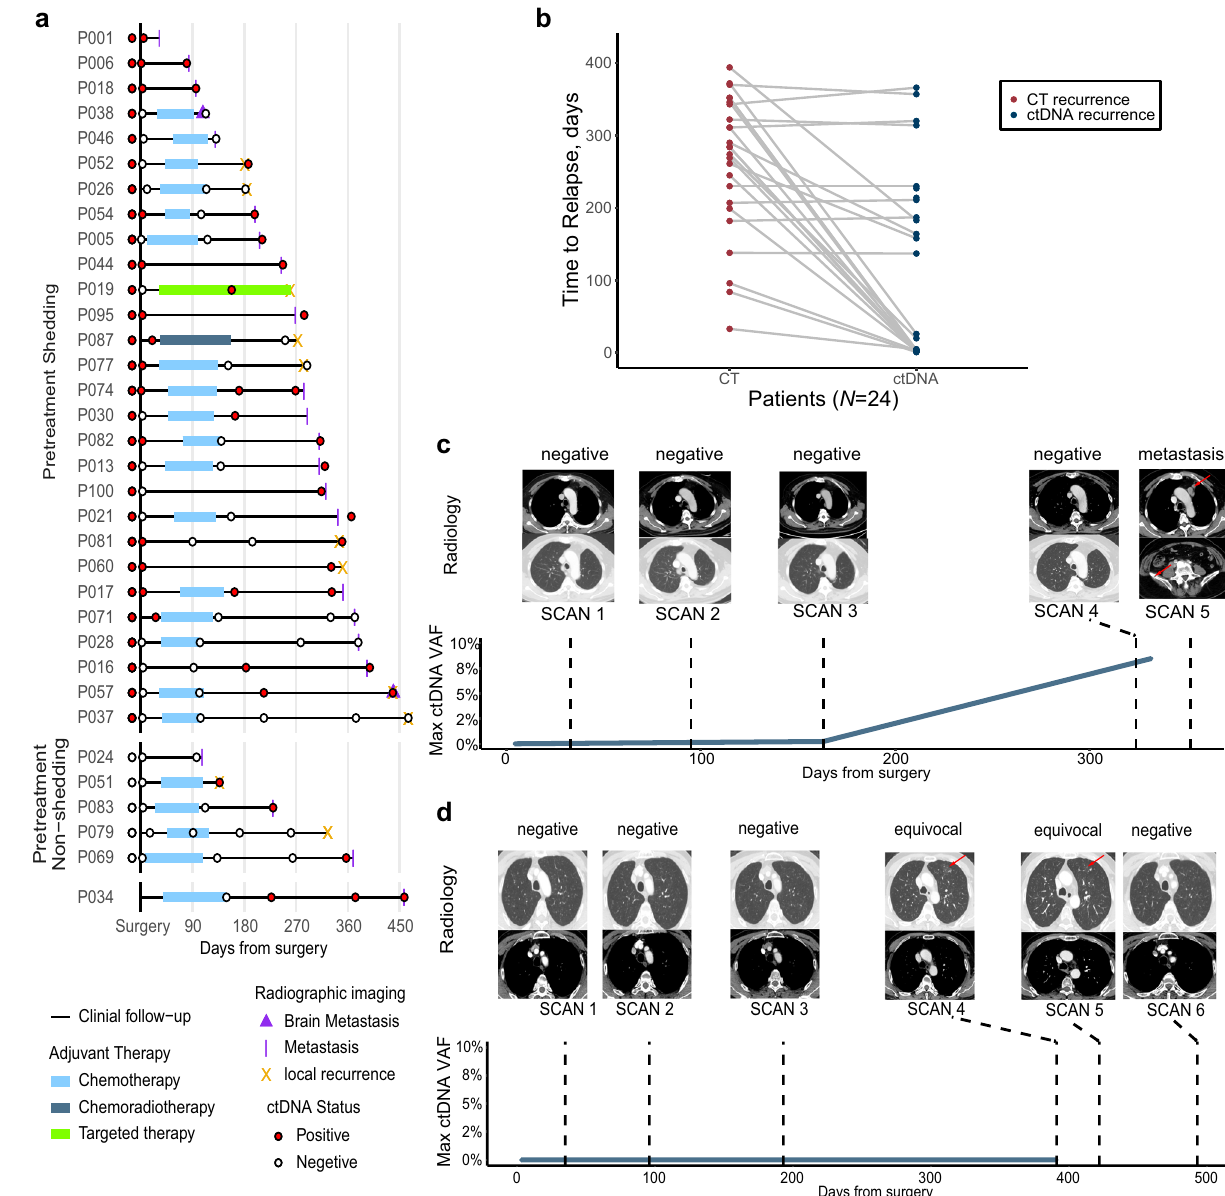
Fig. 3 Longitudinal ctDNA analysis for relapse anticipation and disease monitoring. a The dynamic monitoring of ctDNA in patients with radiological recurrence. Circles represented ctDNA status. Treatment and imaging information was indicated for each patient. Patients were separated based on their pretreatment ctDNA shedding status. b The comparison of the recurrence time measured by ctDNA versus computed tomography (CT). Two-sided Wilcoxon two-sample paired signed-rank test, p < 0.001. c CT scan and ctDNA detection for patient P017. d CT scan and ctDNA detection for patient